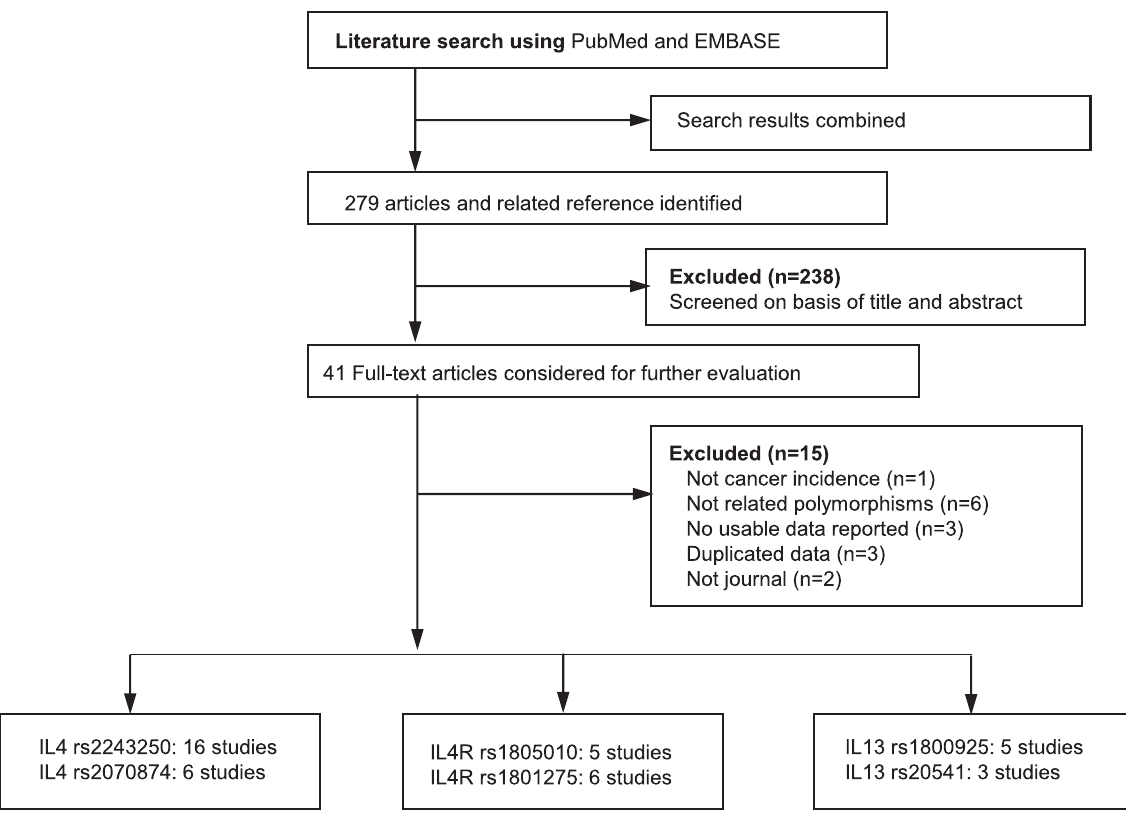
Fig. 1. Flowchart depicting the literature search and selection.